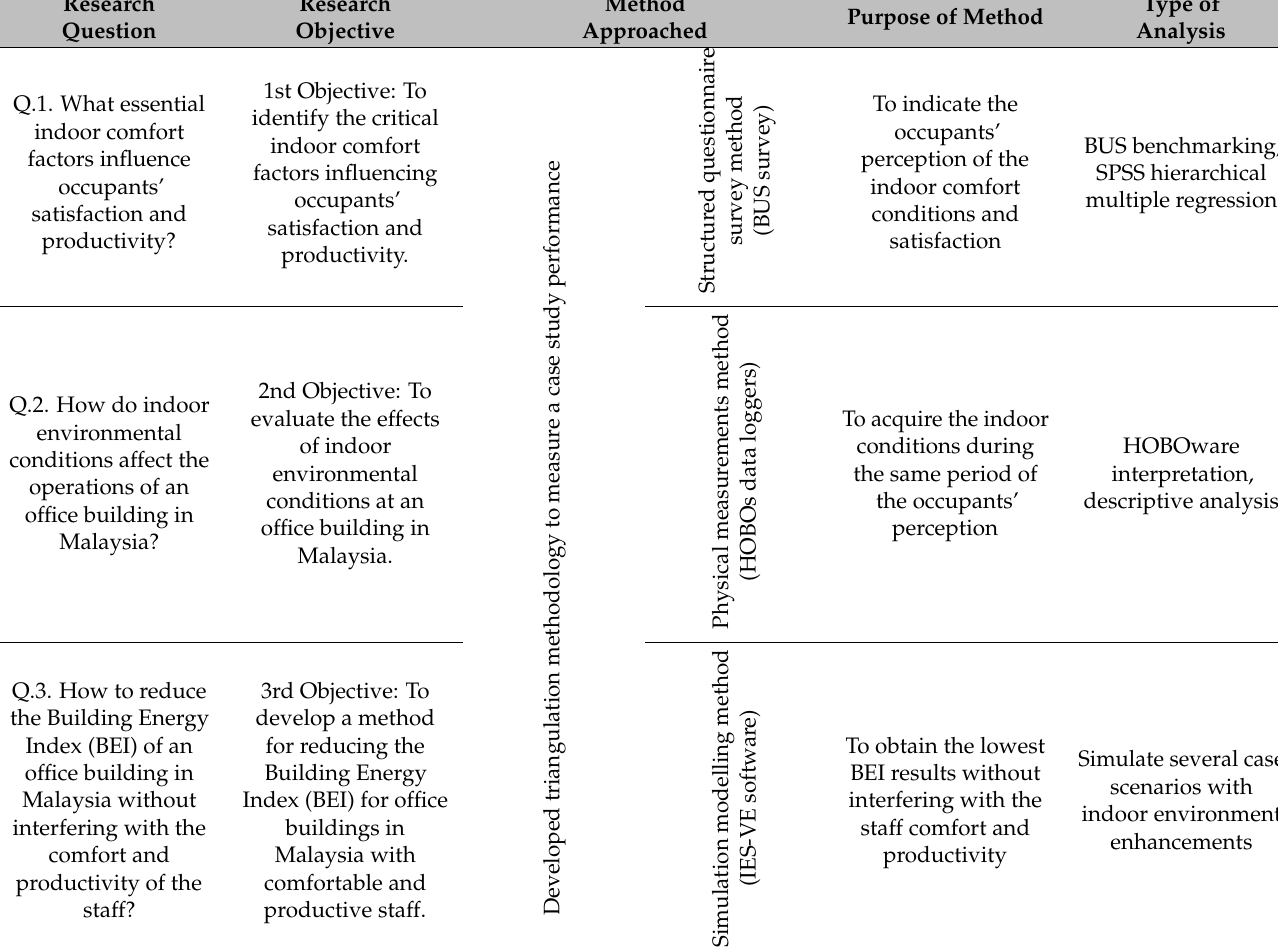
Table 1. Summary of Research